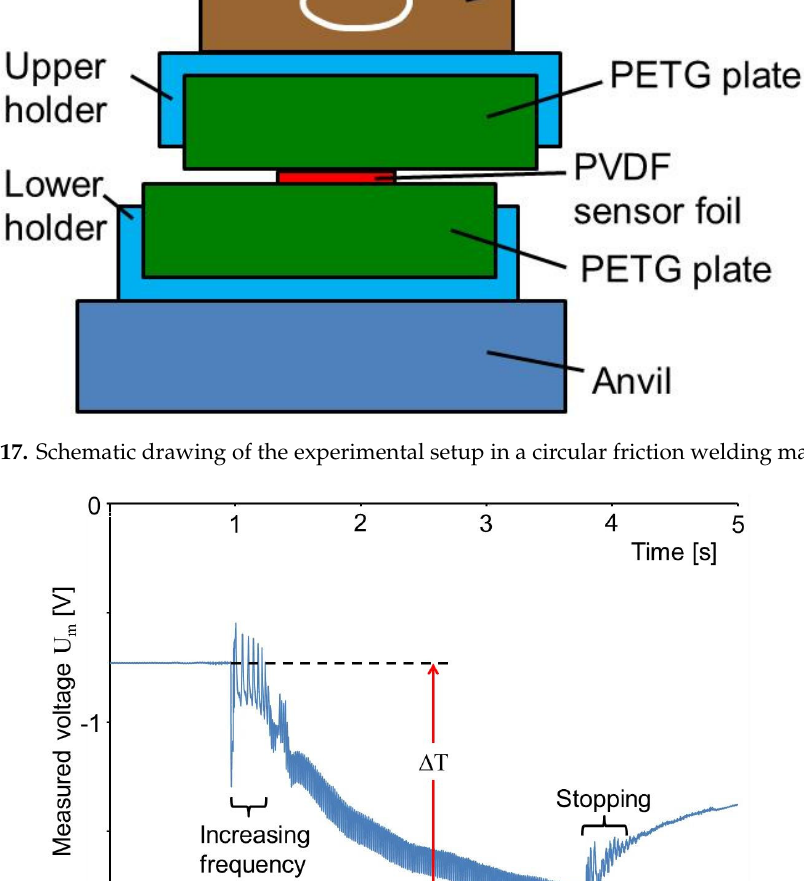
Figure 17. Schematic drawing of the experimental setup in a circular friction welding machine.